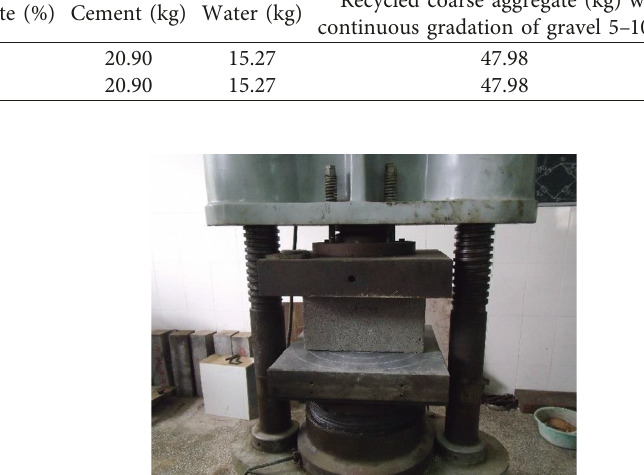
Figure 4: Specimen of the loading device.